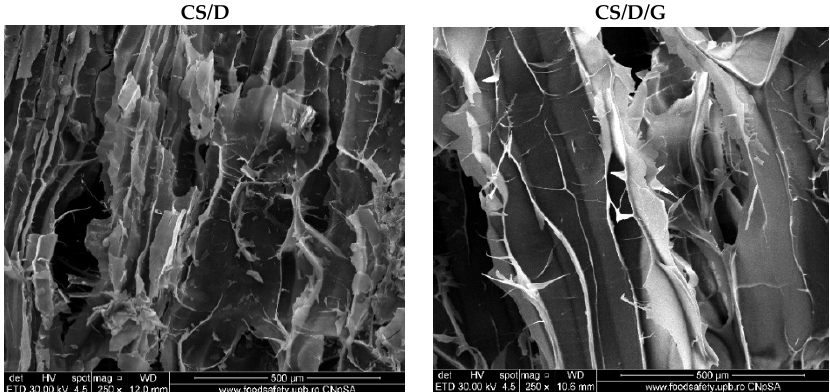
Figure 3. SEM images of the control CS/D and CS/D/G hydrogels (ETD detector).